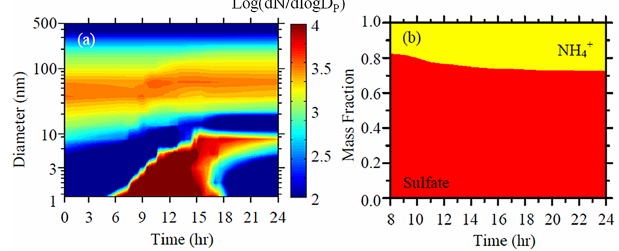
Figure 2. Simulation with surface tension σ = 0.025Nm − 1 at Hyytiälä: (a) predicted particle size distribution with number con- centration plotted against time of day ( x axis) and particle diameter ( y axis) and (b) the composition of new